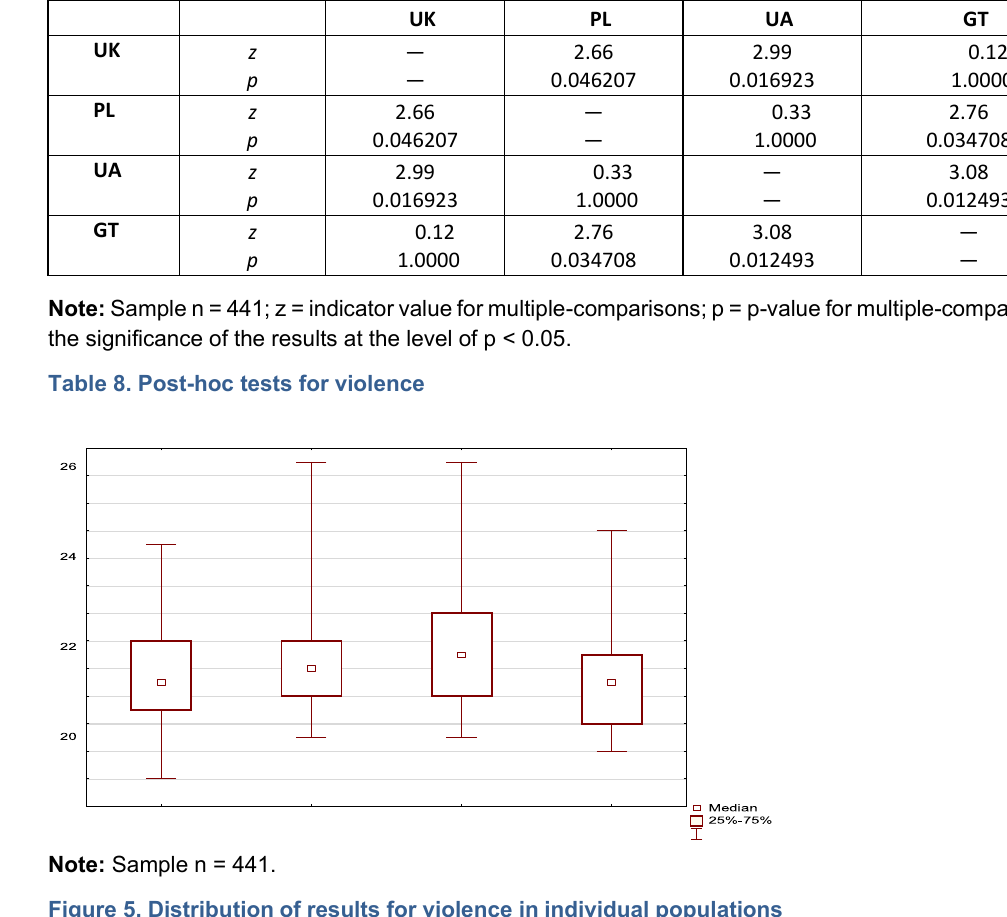
Figure 5. Distribution of results for violence in individual populations